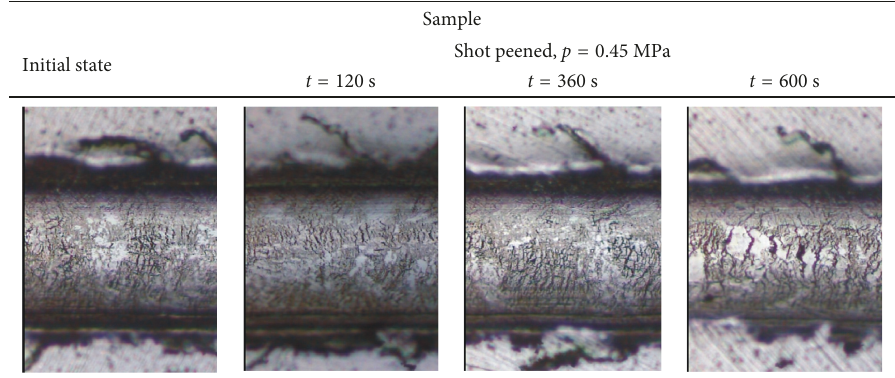
Figure 14: A fragment of the scratches corresponding to the load from the range of 37–42N for CrN coatings deposited on shot peening–treated substrates and the untreated